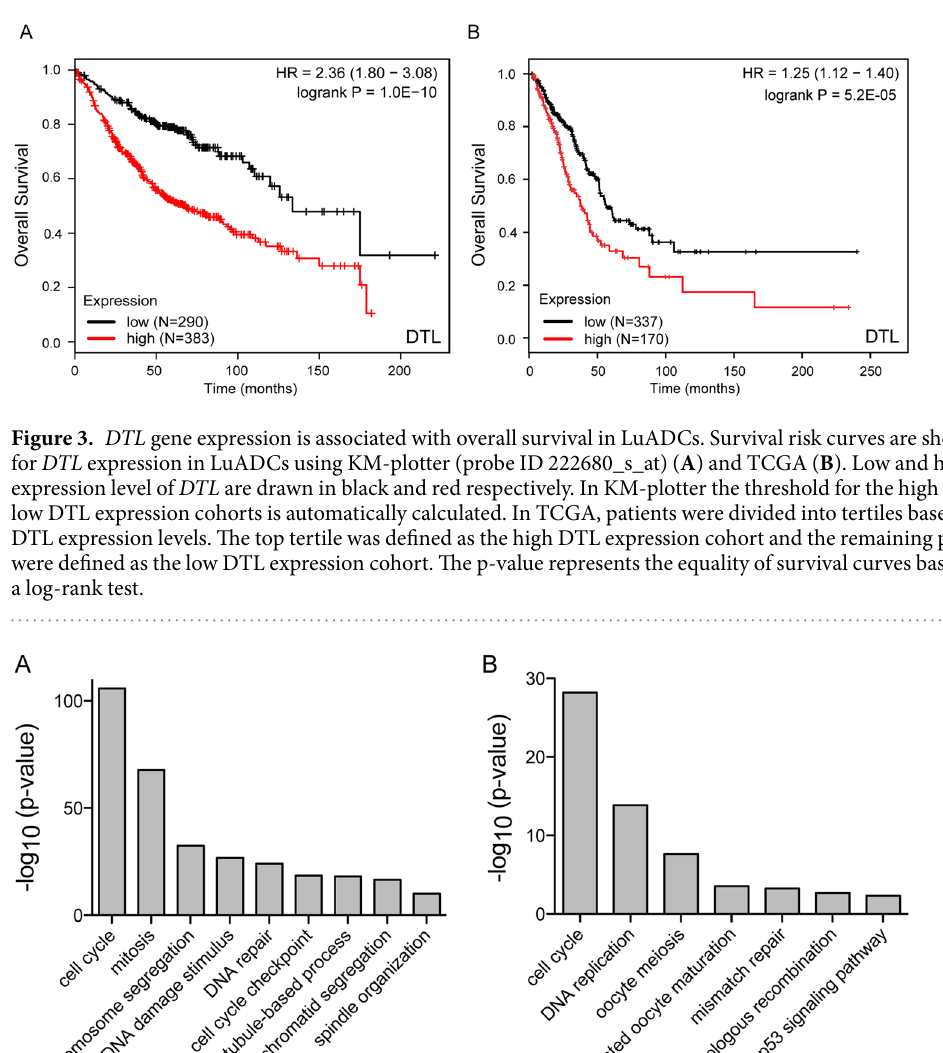
(Fig. 5). PDCD4, NKX2-1 and PRKAA1 (AMPKA1) are well known tumor supressor genes, and our result sug- gests that DTL downregulates these genes.